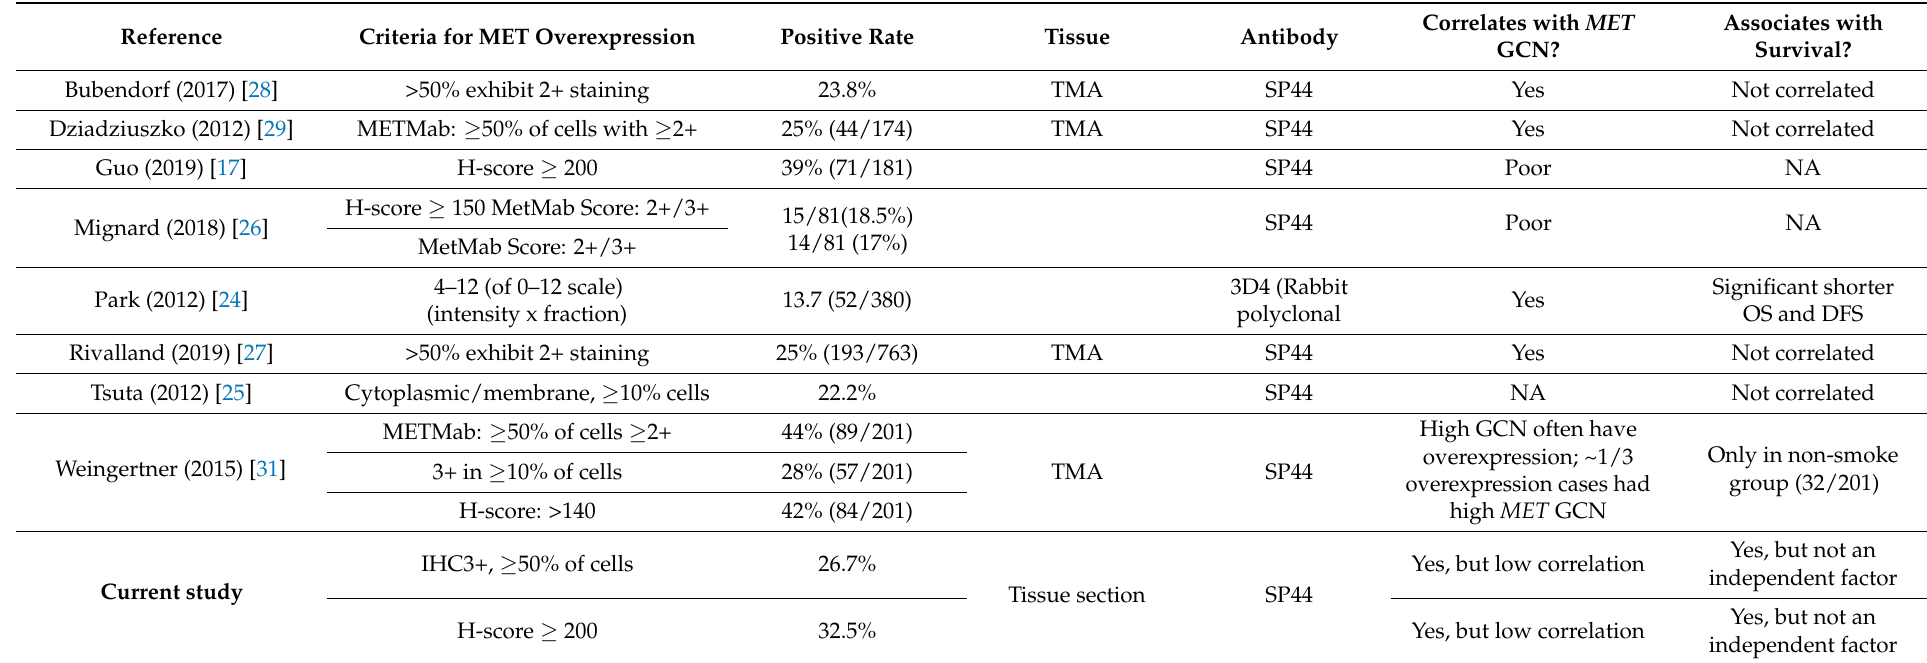
Table 5. Current and Previous Studies on MET Overexpression and the Associations with MET Copy Number /Patient